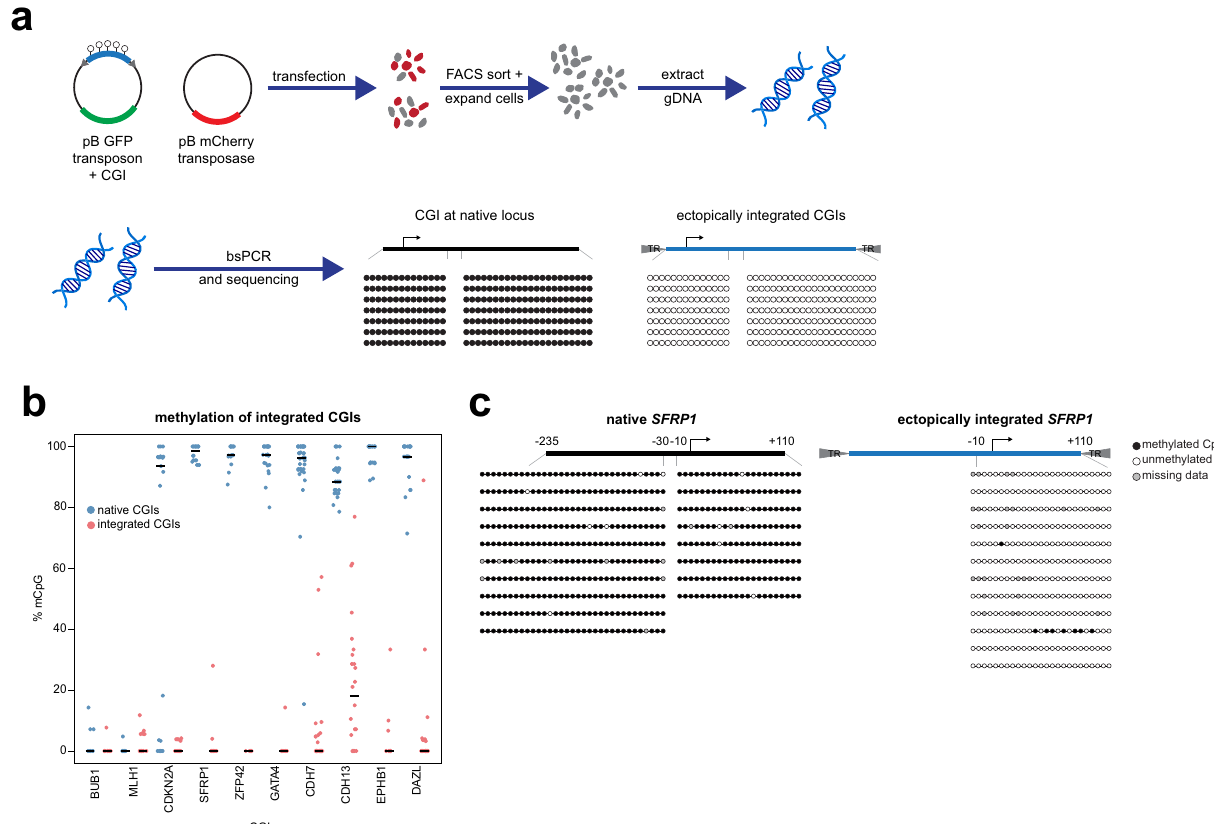
Fig. 1 CGIs are not de novo methylated at ectopic locations in colorectal cancer. a Schematic of experimental approach. Cells are transfected with piggyBac (pB) transposons containing unmethylated CGI DNA sequences along with the pB transposase. Transfected cells are selected by FACS based on fl uorescent markers encoded by the plasmids and expanded to dilute out unintegrated copies of the plasmids. Genomic DNA is then extracted and subject to bisul fi te PCR (bsPCR) to assay DNA methylation levels at the native and integrated copies of the CGI. b Ectopically integrated aberrantly methylated CGIs do not become de novo methylated in HCT116 cells. Plot showing the mean methylation per clone as assayed by bsPCR for 10 CGIs in their native location and when ectopically integrated in a piggyBac transposon. Each point represents the mean methylation level for a single bsPCR clone. The thick line indicates the median for each CGI. The number of clones analysed per CGI is indicated in Supplementary Table 1. c SFRP1 is not hypermethylated when integrated into ectopic locations in HCT116 cells. Illustrative example bsPCR data from panel b showing the SFRP1 promoter CGI in its native and integrated state. Circles are CpGs with different clones arranged vertically. Each integrated clone derives from a separate genomic integration. Black circles are methylated CpGs and white circles are unmethylated CpGs. Grey circles represent missing data due to sequencing errors. Source data are provided as a Source Data fi